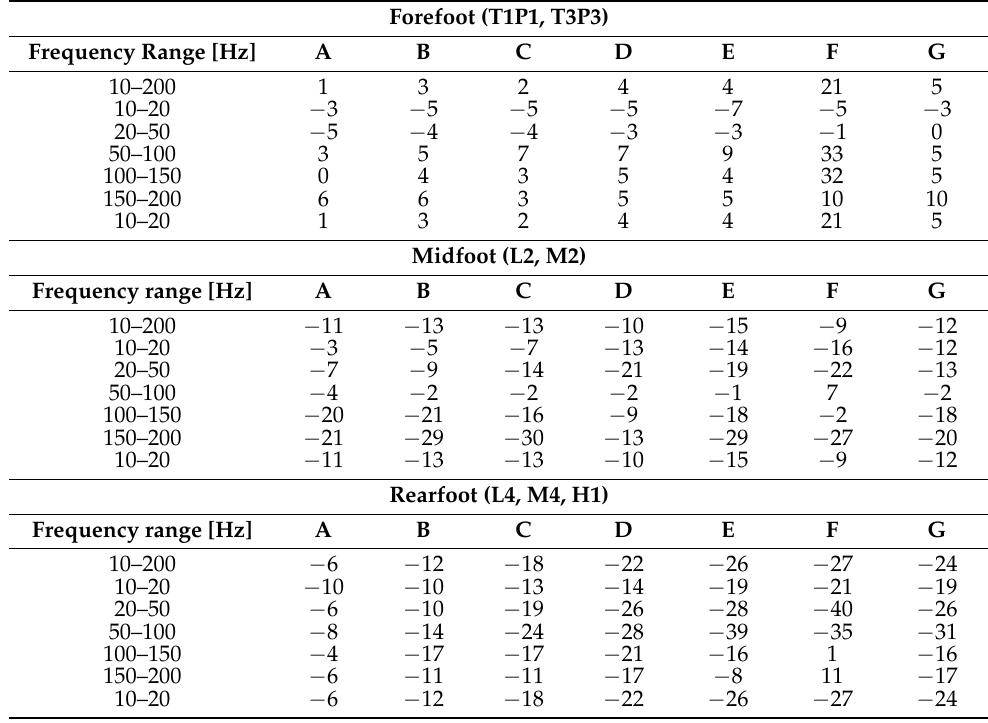
Table 2. Difference (%) between the average vibration transmissibility measured with the different insoles and that measured in barefoot at the toes, at the midfoot and at the rearfoot.